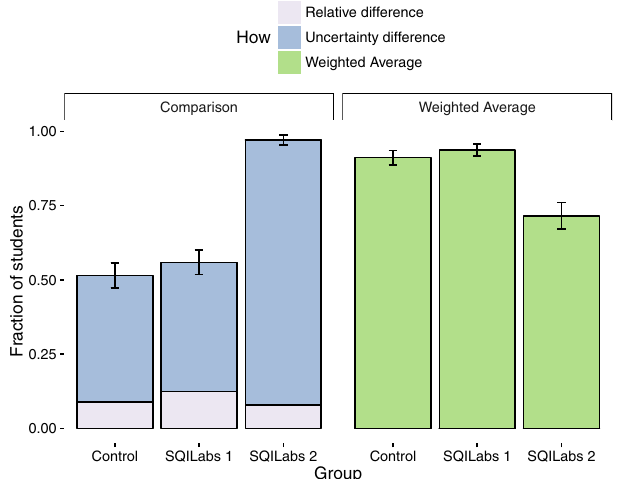
FIG. 2. The distribution of whether and how students analyzed their data, either using a weighted average to combine measure- ments or to compare their measurements. Students compared measurements by comparing either the relative difference between the measurements or the difference relative to the uncertainty.